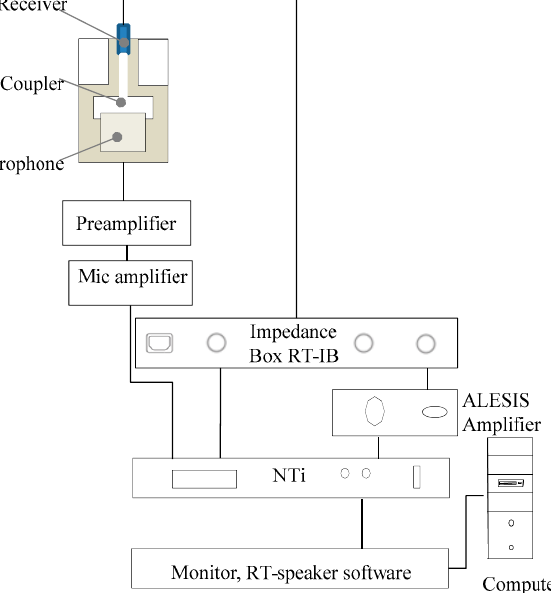
Figure 12. Experimental condition.